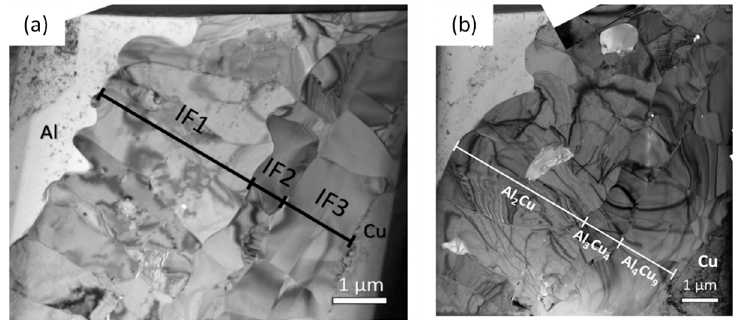
Figure 13. TEM images and SAED patterns of the substructure evolution after ECAP [88]: ( a ) no back pressure; ( b ) with back pressure. Reproduced with permission from Elsevier Ltd.